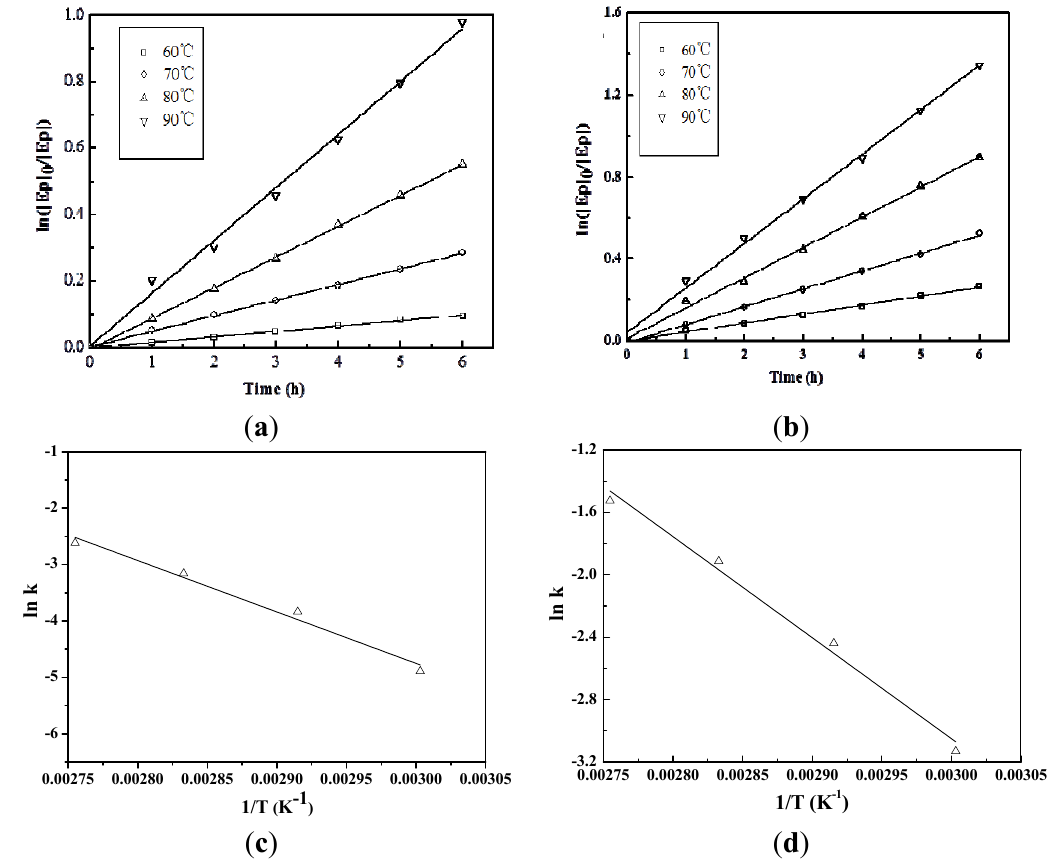
Figure 2. ( a ) Determining the rate constant k ′ at different temperatures without catalyst. Experimental conditions: 2-EH/oil ratio 10:1, 6 h reaction time, without catalyst; ( b ) Determining the rate constant k ′ at different temperatures with the D001 resin catalyst. Experimental conditions: 2-EH/oil ratio 4:1, 6 h, 7 wt % Amberlyst D001 (dry); ( c ) Determining the activation energy ( Ea ) without a catalyst; ( d ) Determining the